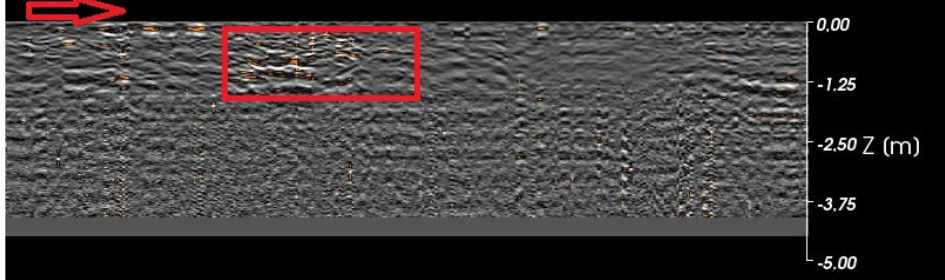
Figure 4. Radargram image. The red arrow indicates the direction of the pass and the red rectangle shows the alterations detected to the northeast of the archaeological site.